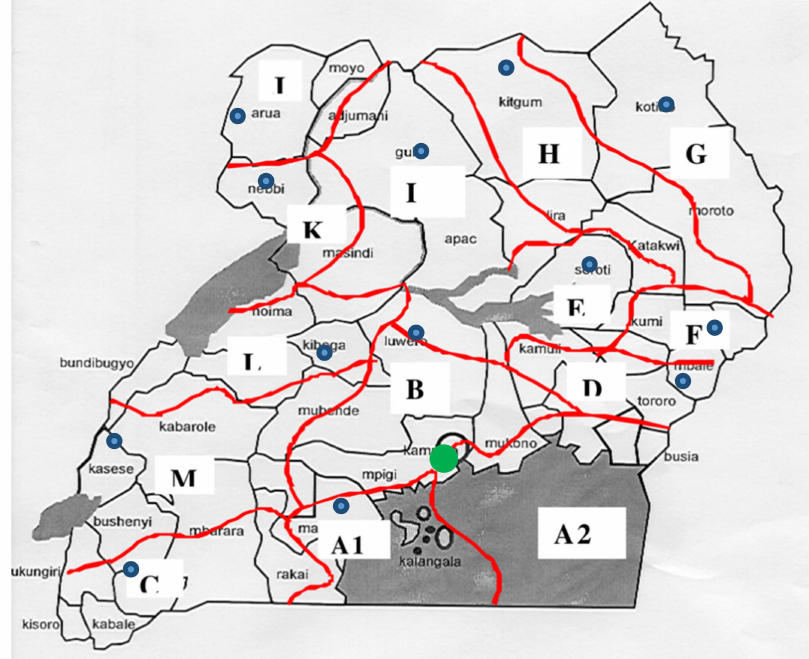
Figure 1. Map of Uganda showing the climatic zones of Uganda that were used in this project (adapted from Reference [26]). The locations listed in Table A1 are shown as blue dots on the map, and the location that was also the site of radiosonde launches (Entebbe) is shown as a large green